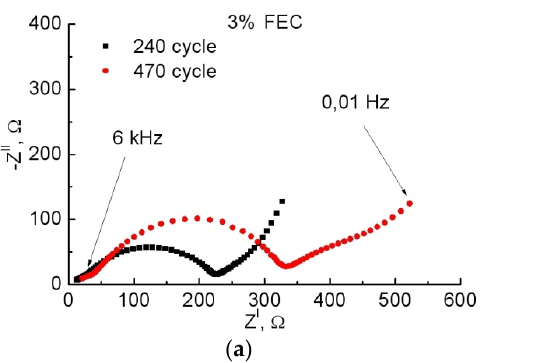
Figure 11. Impedance hodographs for samples with 3% ( a ) and 0% ( b ) FEC as a function of the cycle numbers.